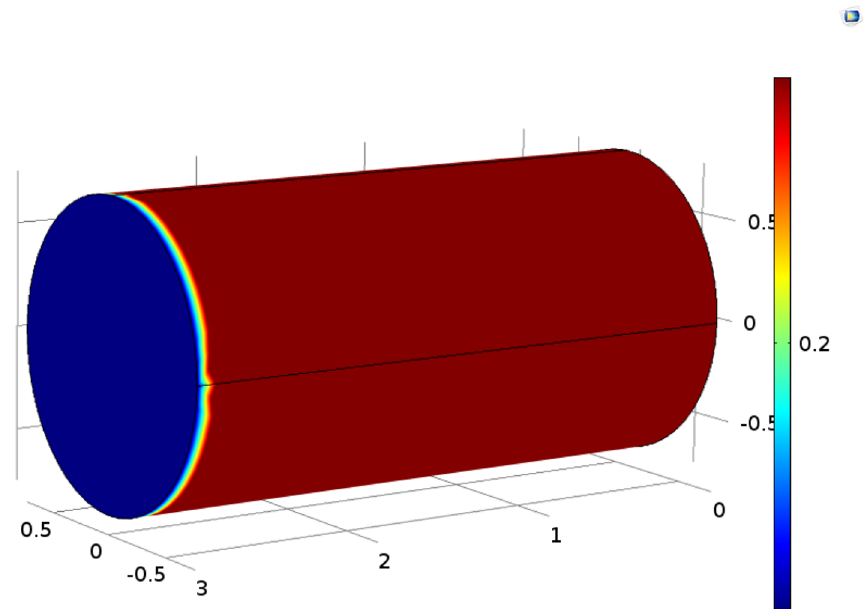
Fig. 16 Initial fast-reacting mineral distribution at the beginning of acid